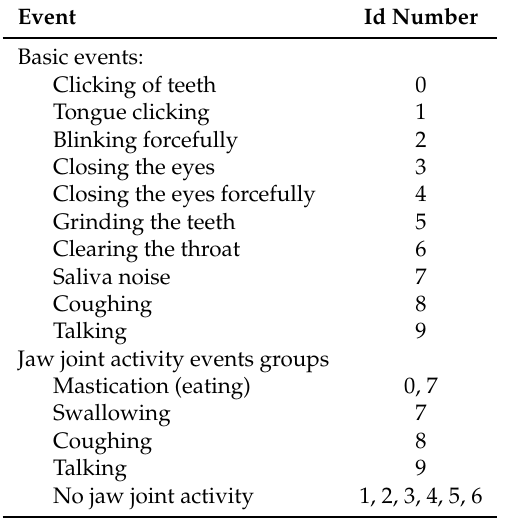
Table 1. Verbal and nonverbal audio events detected by the classification